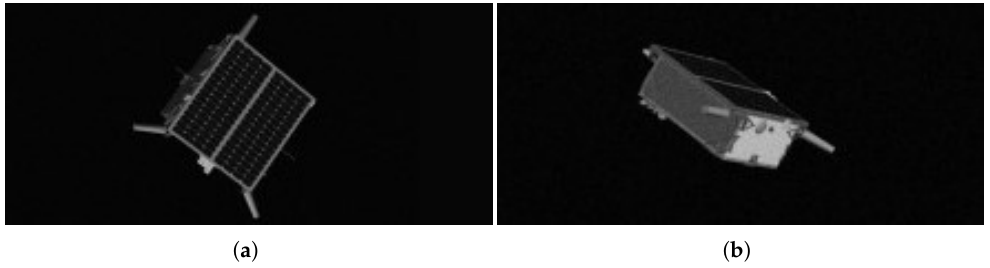
Figure 8. Examples of the simulated data: ( a ) example 1; ( b ) example 2.